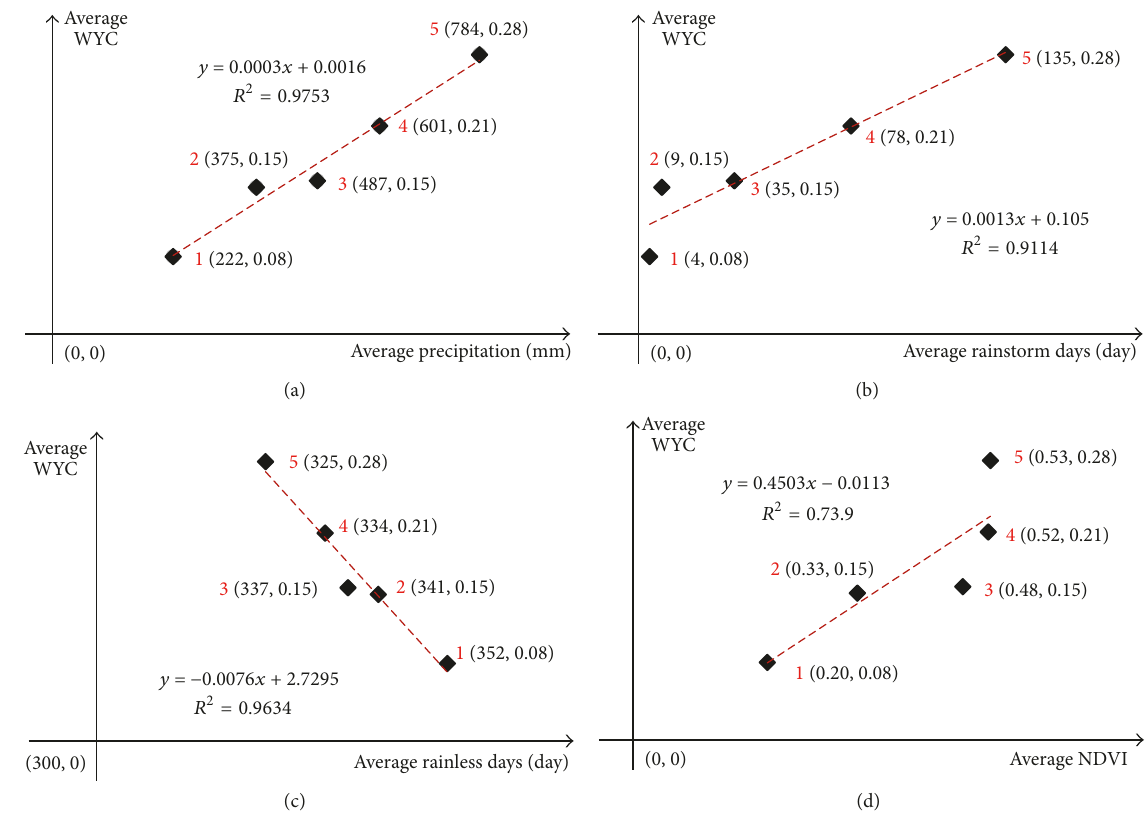
Figure 25: The coupled relationships between average WYC and four factors from 1982 to 2011.